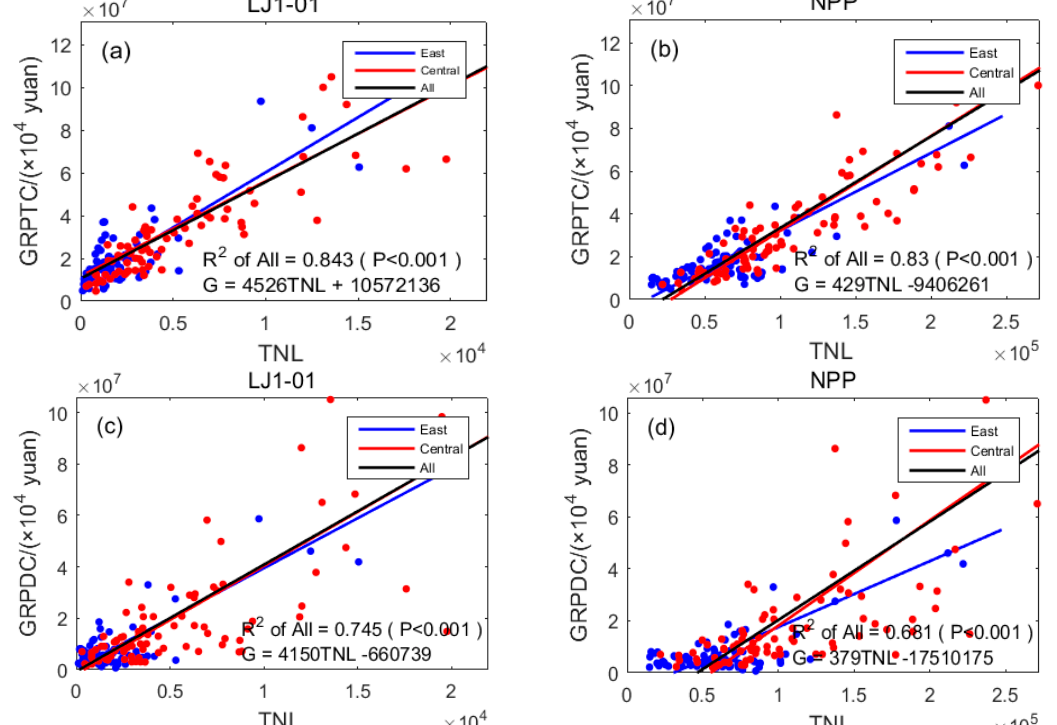
Figure 3. Scatter diagrams for linear regression results of GRP and TNL: ( a ) TNL of LJ1-01 data and GRPTC; ( b ) TNL of NPP/VIIRS data and GRPTC; ( c ) TNL of LJ1-01 data and GRPDC; ( d ) TNL of NPP/VIIRS data and GRPDC.